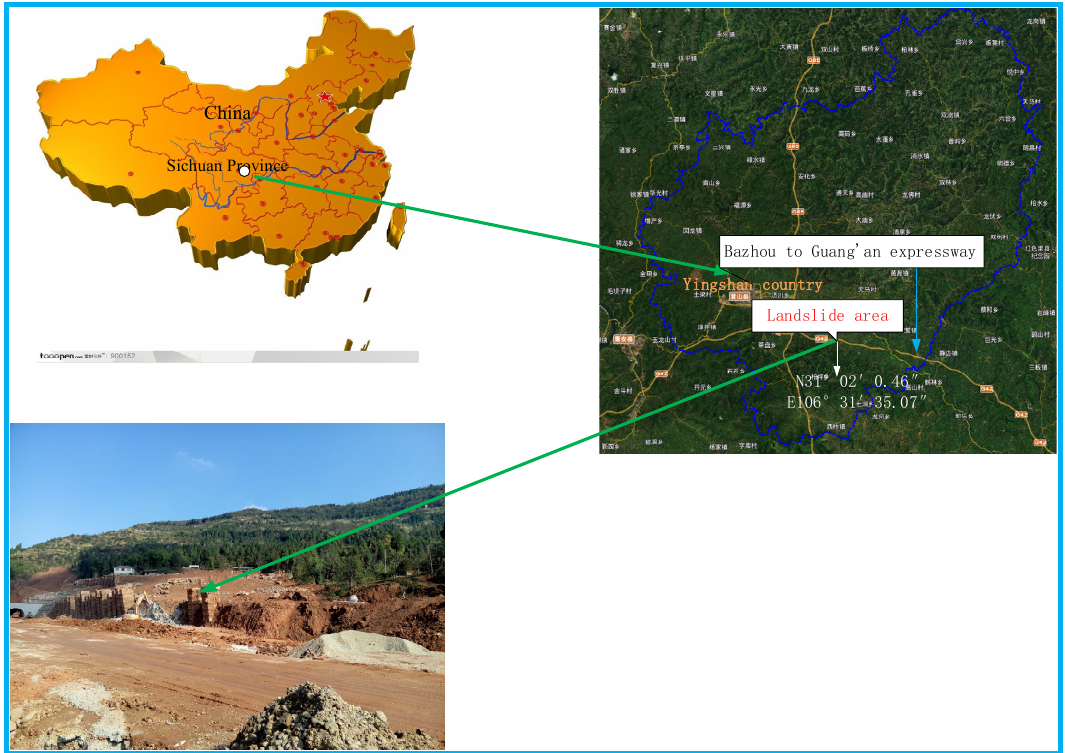
Figure 1. LandslideLocation. Thefieldissubtropicalmonsoonclimate,andtheaverageannualprecipitation Figure 1. Landslide Location. The field is subtropical monsoon climate, and the average annual is 980–1150 precipitation is 980–1150 mm.